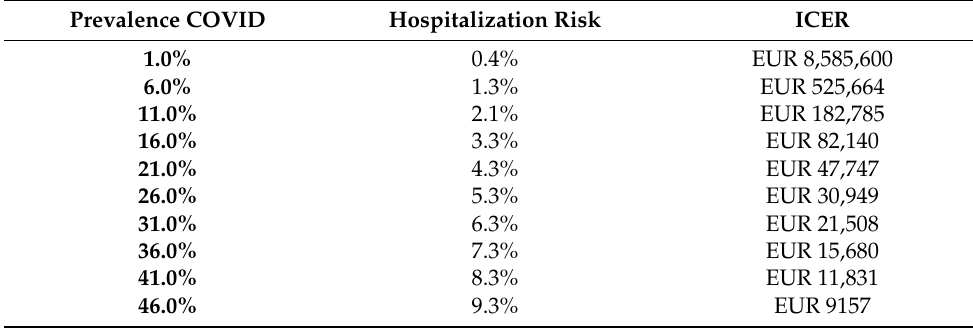
Table 5. Two-way sensitivity analysis secondary outcome (reducing hospital